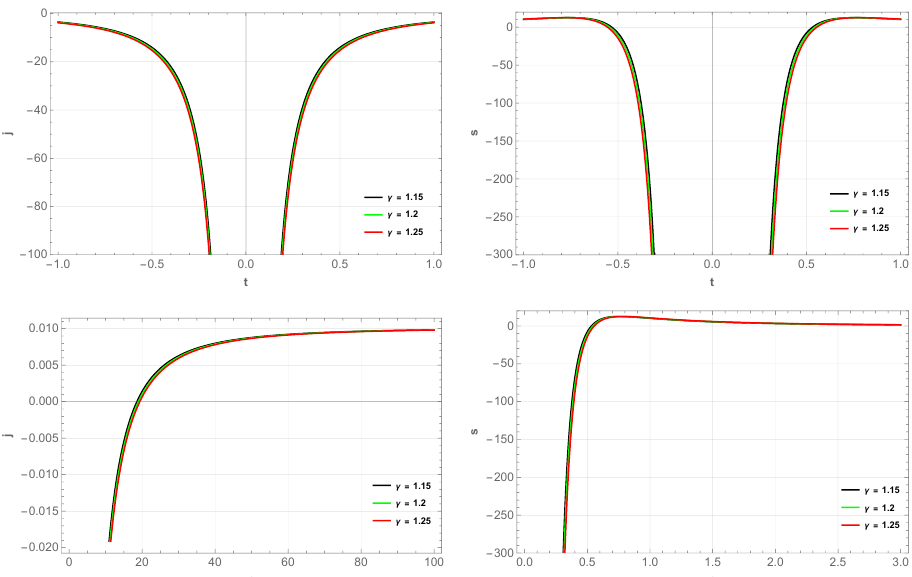
Figure 8. Symmetric behavior of the jerk parameter ( above left panel ) and snap parameter ( above right panel ) versus cosmic time t . The jerk ( below left panel ) and snap ( below right panel ) parame- ter in positive time domain with λ =